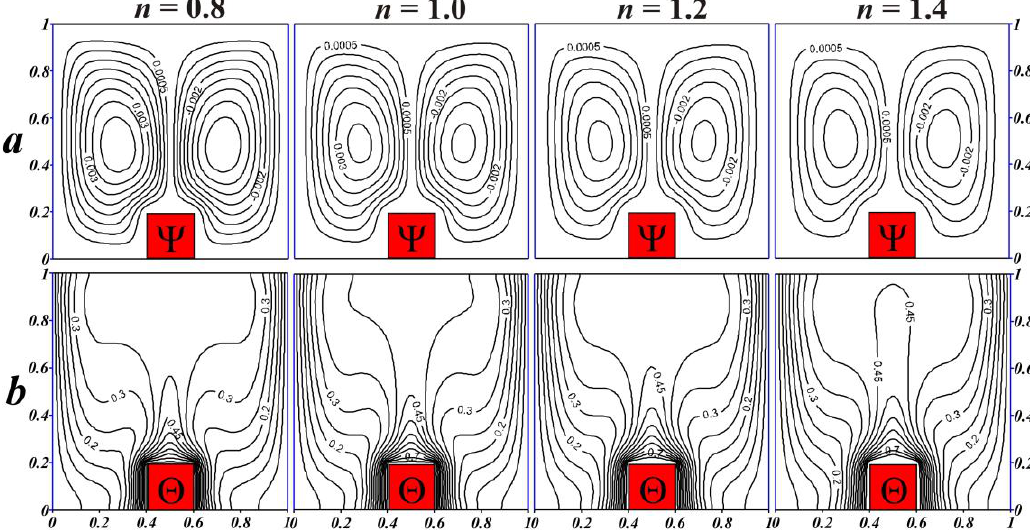
Figure 7. Streamlines Ψ ( a ) and isotherms Θ ( b ) at Pr = 10 2 , k = 10 2 , Ra = 10 5 and different n.